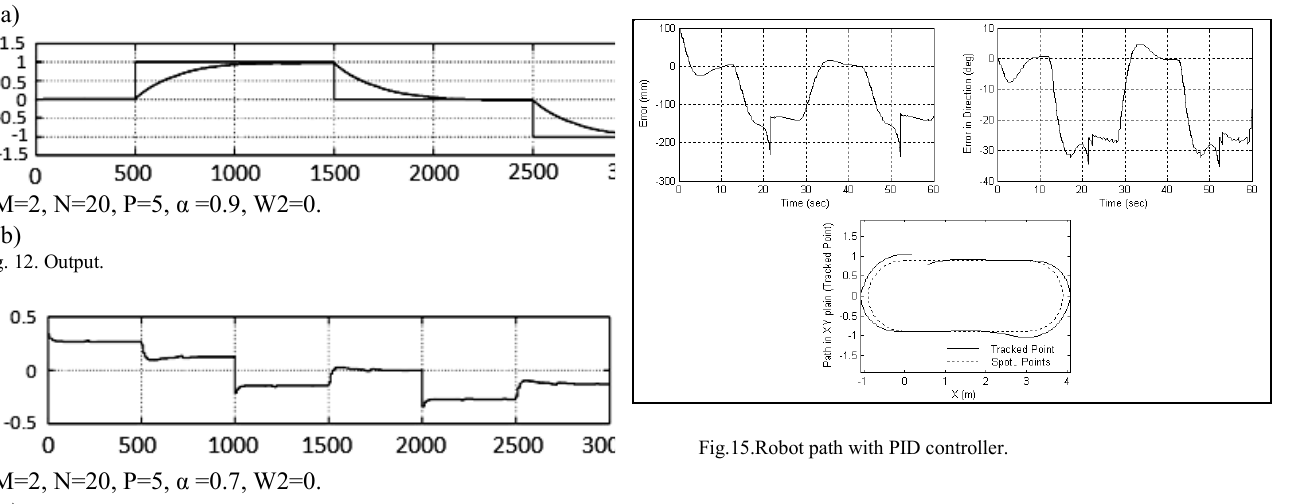
Fig.15.Robot path with PID